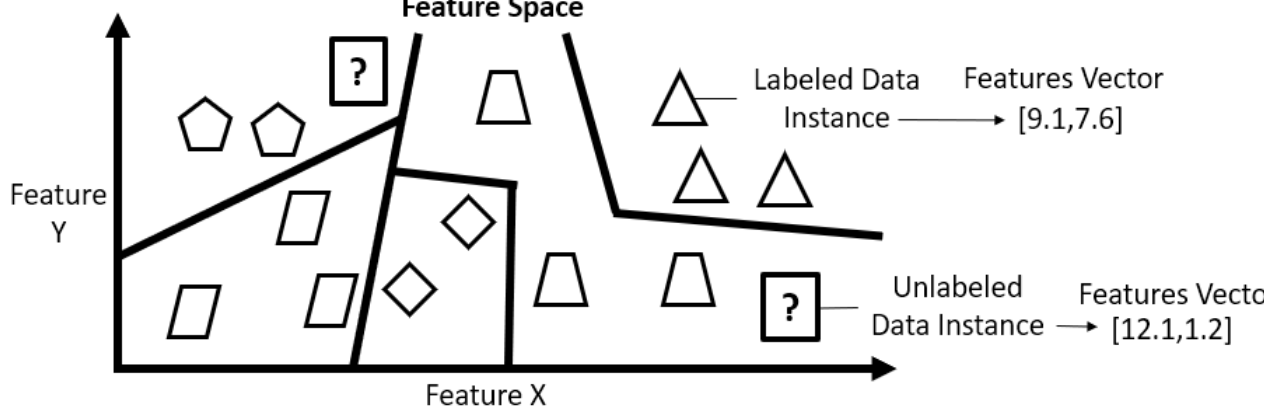
Figure 8. Example of a two-dimensional feature space.